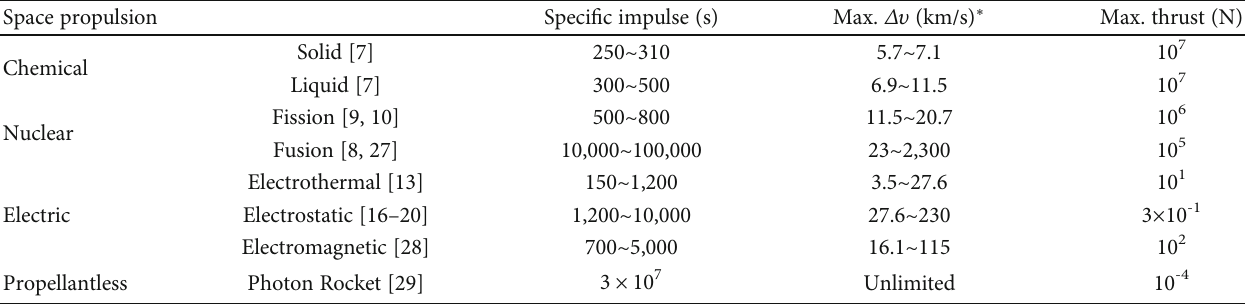
Table 1: Performance of space propulsion systems [26] p.11.